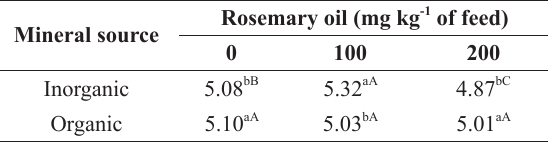
Raw yolk color of eggs of laying hens fed different mineral sources and rosemary oil